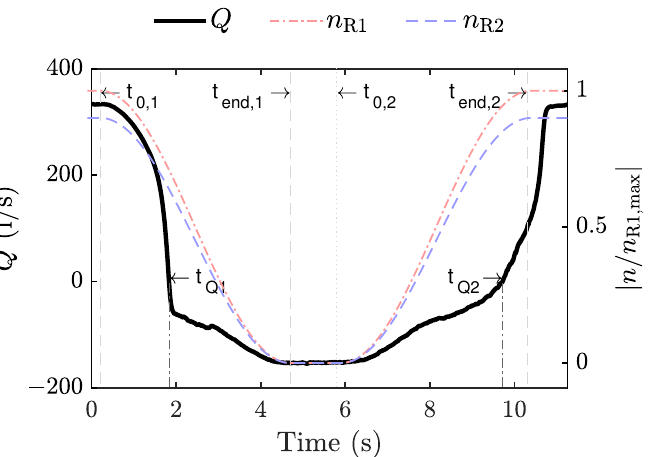
Figure 9. Flow rate (left axis) and runner rotational speeds (right axis) as a function of time during the pump mode transient. The flow rate is defined as positive in the preferred pump mode direction, positive z -direction (see Figure 1b). t Q1 = 1.83 s and t Q2 = 9.72 s indicate the points with zero flow rate. The rotational speeds are normalised with the initial rotational speed of Runner 1. The annotated times correspond to the start/end times of the changes in runner rotational speeds (see Figure